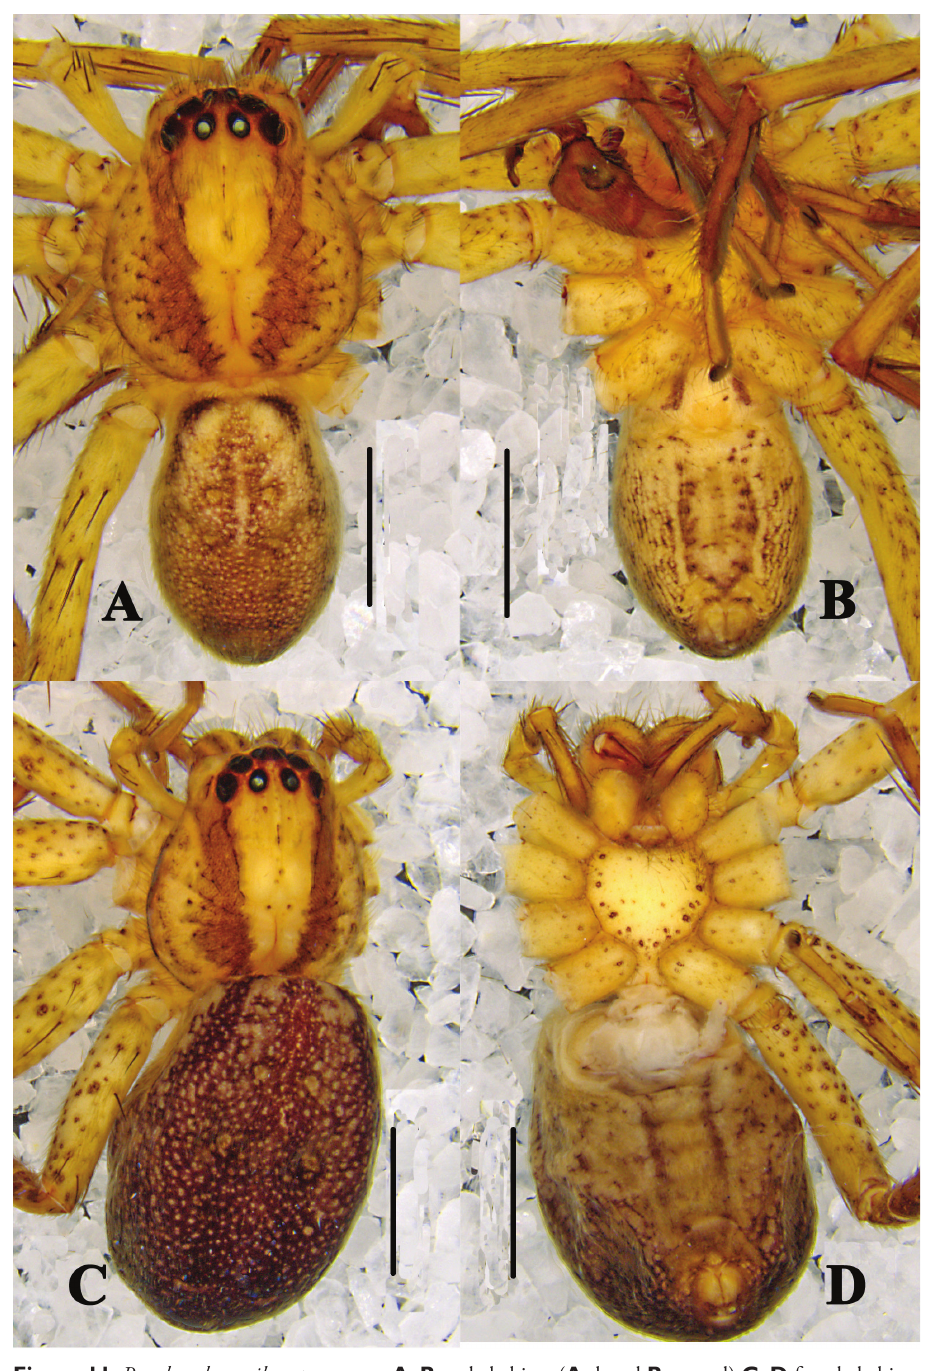
Figure 11. Pseudopoda semilunata sp. nov. A, B male habitus ( A dorsal B ventral) C, D female habitus ( C dorsal D ventral). Scale bars: 2